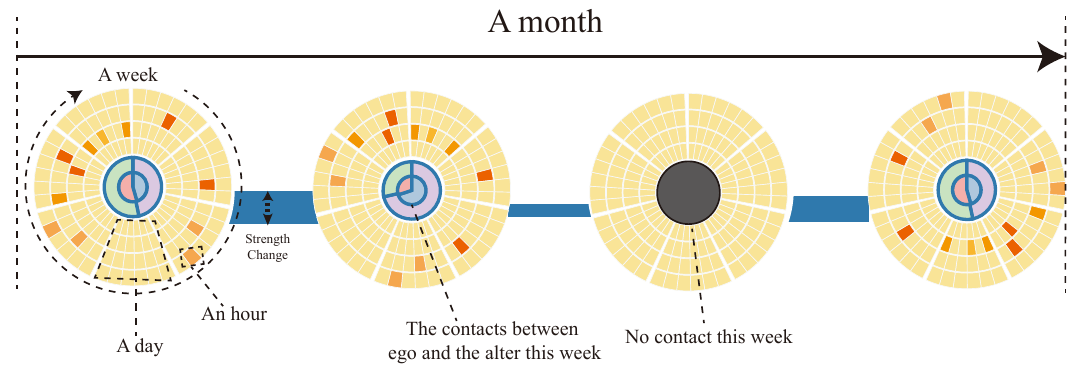
Figure 7. An alternative design for detail view based on circular